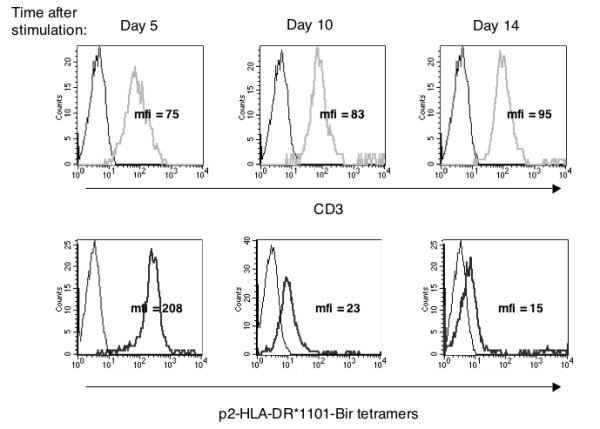
HLA-DR*1101-Bir tetramer staining correlates with the activation state of the target CD4+ T cells. The p2-specific CD4+ TCC 162 was stained with p2-loaded HLA-DR*1101-Bir tetramers at different time after in vitro restimulation with p2 and APCs. The histograms in the upper row display the amount of surface TCR (mfi) expressed by the T cells at the time of tetramer staining, as determined by anti-CD3 staining. The histograms in the lower row show the staining with the p2-loaded HLA-DR*1101-Bir tetramers (mfi) performed at the indicated time after restimulation.